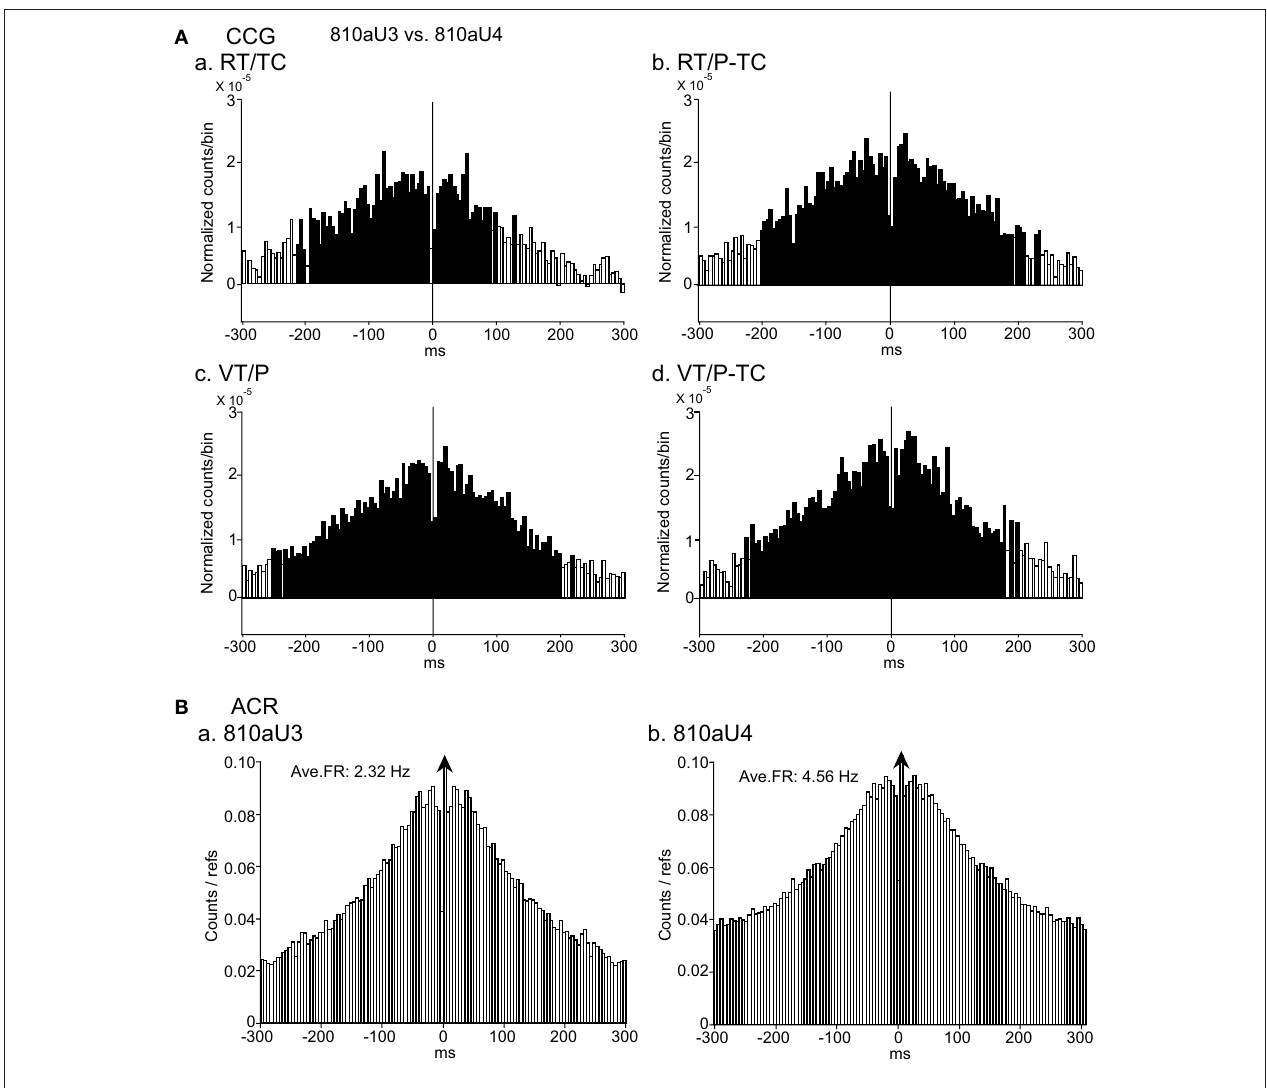
in the RT/TC, 2520 and 5002 spikes in the RT/P-TC, 2672 and 5190 spikes in the VT/P, and 2048 and 4552 spikes in the VT/P-TC tasks, respectively. (B) Autocorrelograms (ACRs; ± 300 ms binning range, 5 ms bin width) of the same neurons in (A) [ (a) 810aU3; (b) 810aU4]. Both neurons